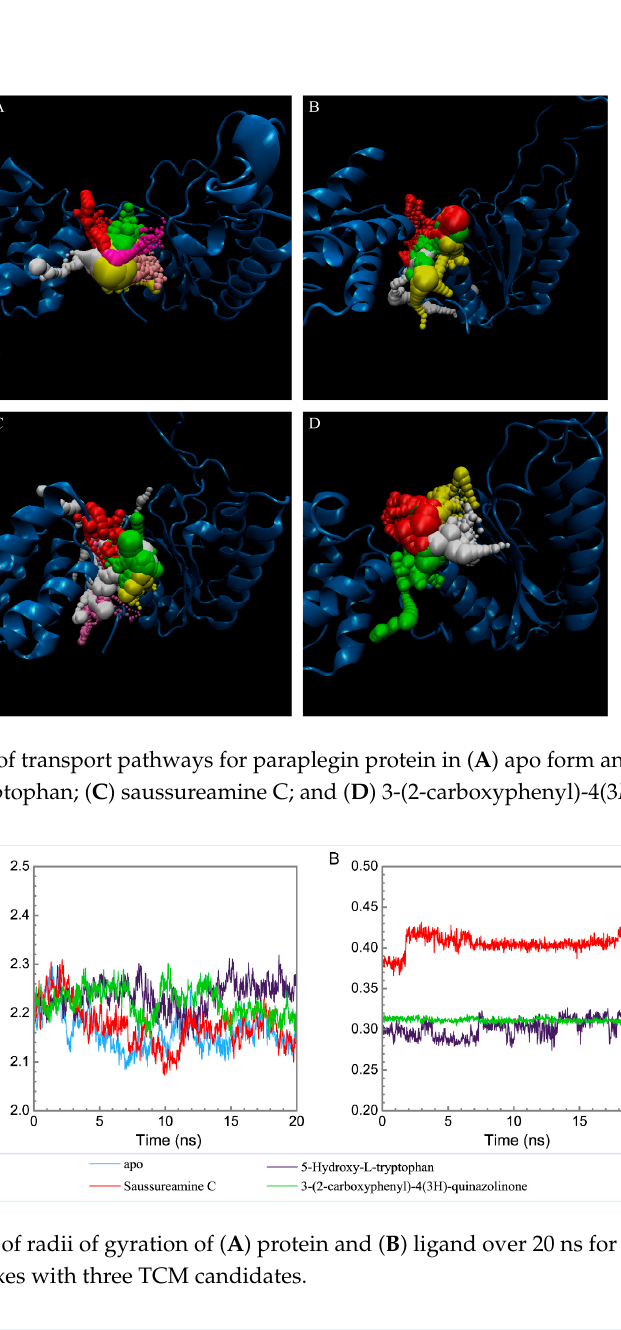
Figure 16. Variation of total solvent accessible surface area of ( A ) protein and ( B ) ligand over 20 ns for paraplegin in apo form and in complexes with three TCM candidates.